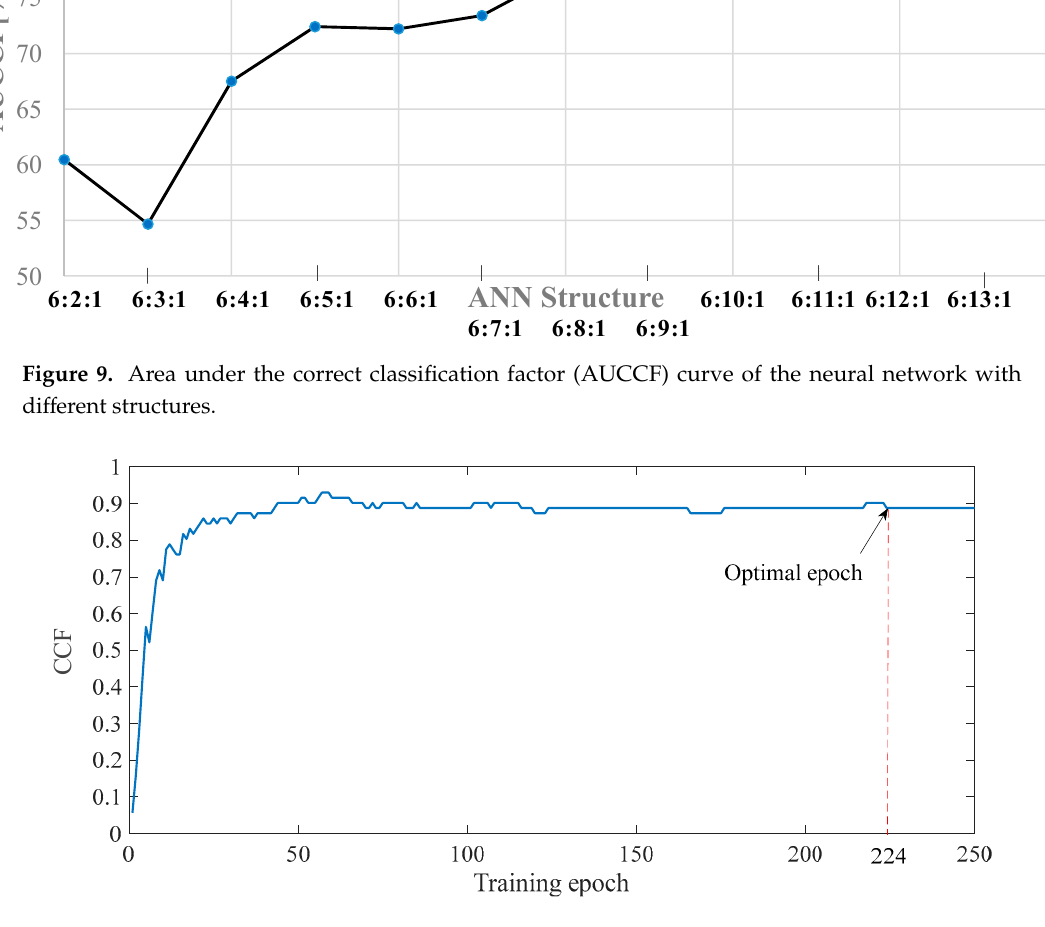
Figure 10. The CCF curve of optimized ANN structure.